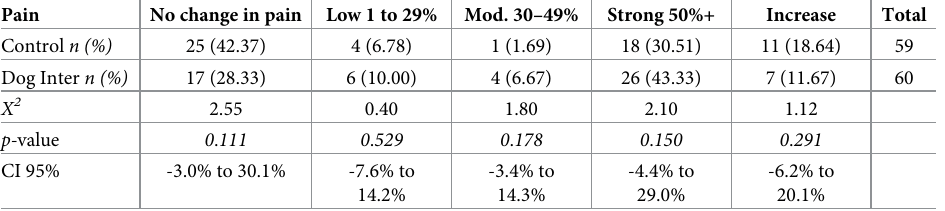
Table 6. Proportion of participants in each pain change response category and chi-square statistics.